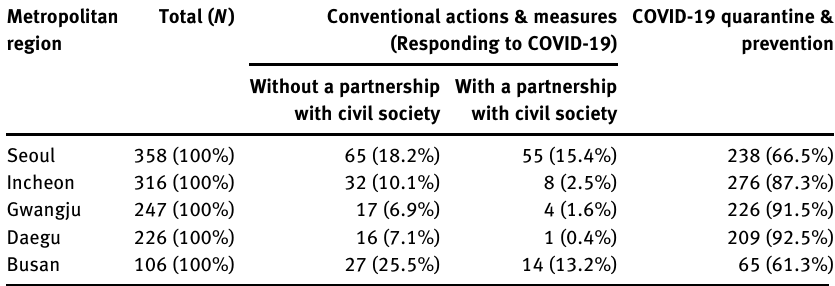
Table  : COVID-related public policies, programs, and